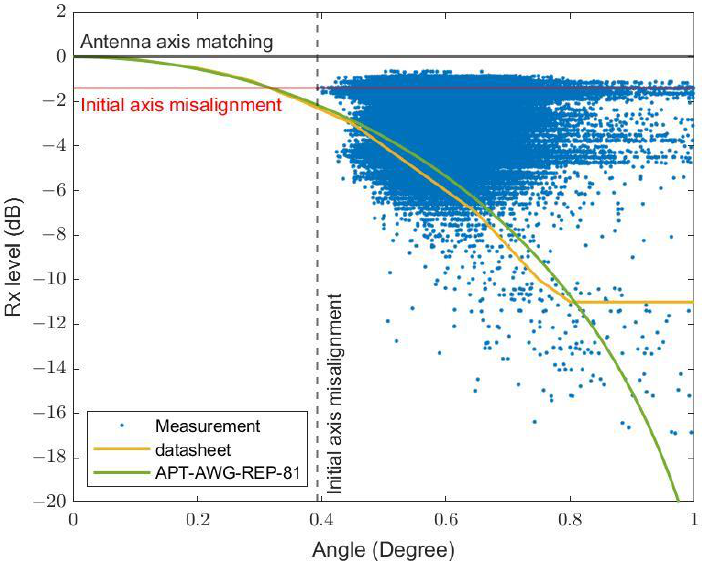
Figure 13. Minimum received signal versus inclination angle magnitude via direct measurement due to wind.